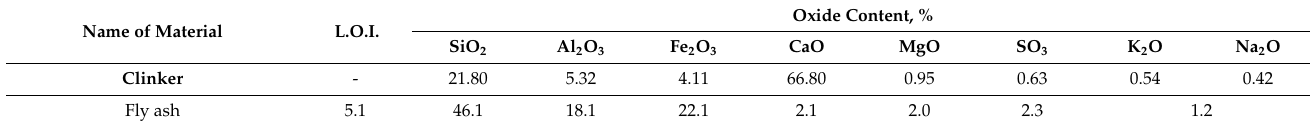
Table 1. Chemical composition of Portland cement *.